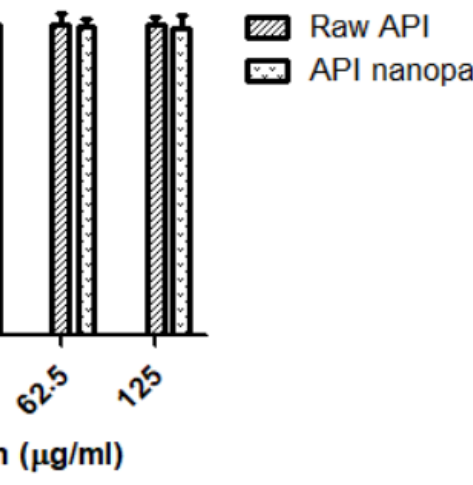
Figure 10. Cell proliferation percent inhibition of raw API and API nanoparticles on RAW264.7 cells.